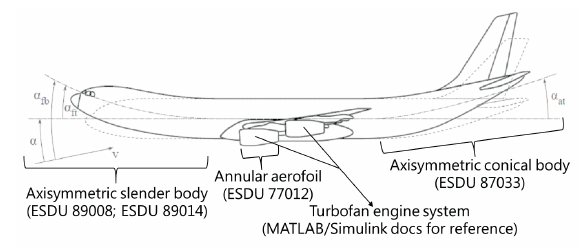
Fig. 5. Flexible fuselage and engines